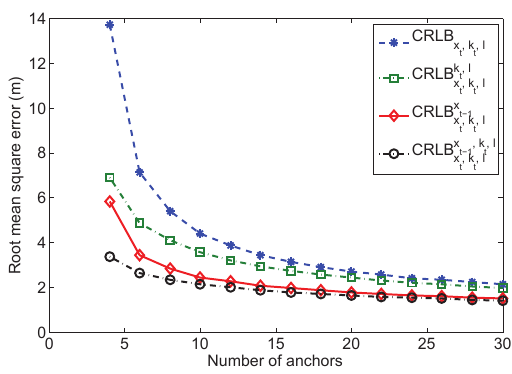
Figure 8. Cramér–Rao lower bound with different number of anchors.